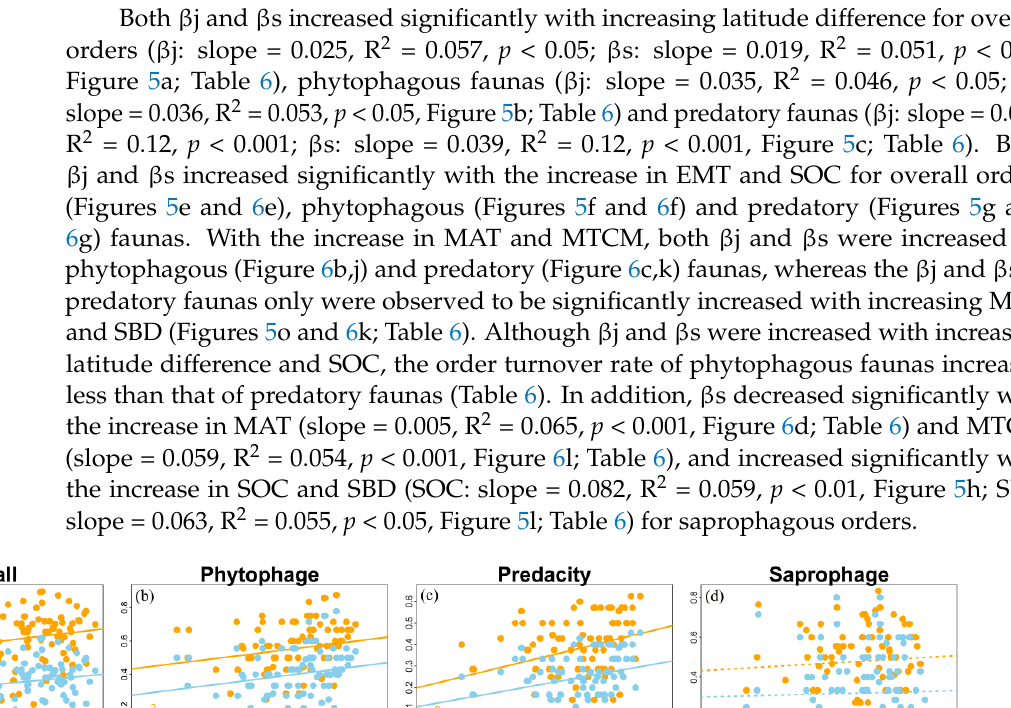
The blue and red arrows represent environmental factors and orders, respectively. The red circles, green squares and blue diamonds represent temperate, subtropical and tropical zones, respectively. In the graphs, MAT = mean annual temperature, MTCM = mean temperature of the coldest months, EMT= extreme minimum temperature, MAP = mean annual precipitation, SOC= soil organic carbon and SBD = soil bulk density. Climate factors include MAT, MTCM, EMT and MAP. Soil factors include SOC and SBD. Order name abbreviations are shown in Table 3. Note: “*” indicates p ≤ 0.05 and “**” indicates p ≤ 0.01.